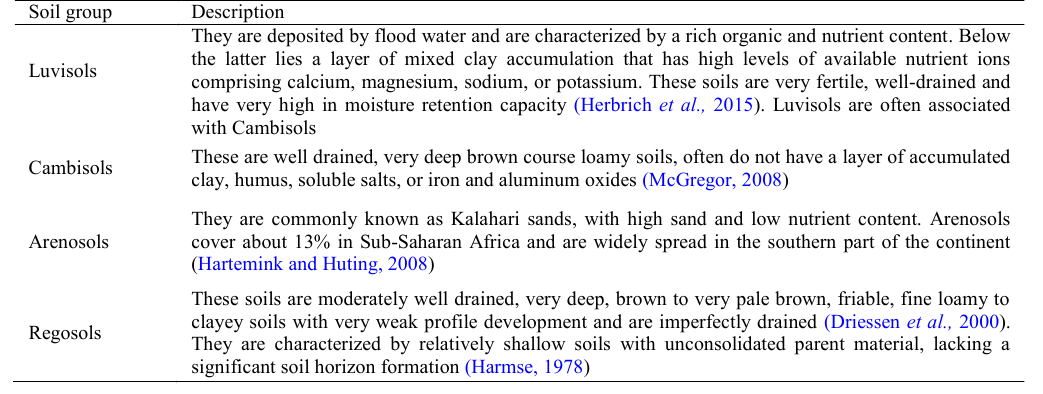
Table 1: Description of major soil types (FAO, 2012) found in Mapungubwe Cultural Landscape, Limpopo Province, South Africa Soil